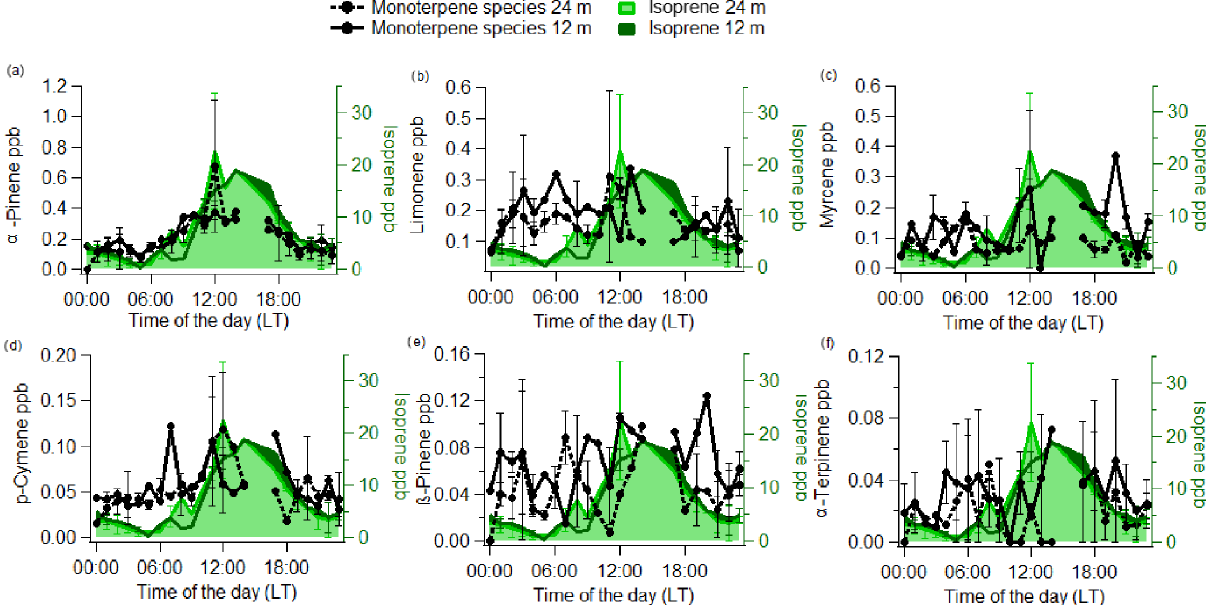
Figure 2. Average diel cycles for α -pinene (a) , limonene (b) , myrcene (c) , ρ -cymene (d) , β -pinene (e) and α -terpinene (f) mixing ratios for 24m (dashed line) and 12m (thick line). In the background, average diel cycles of isoprene mixing ratios as measured by the GC-FID are shown for 24m (light green) and 24m (dark green). Error bars represent the standard deviation of the